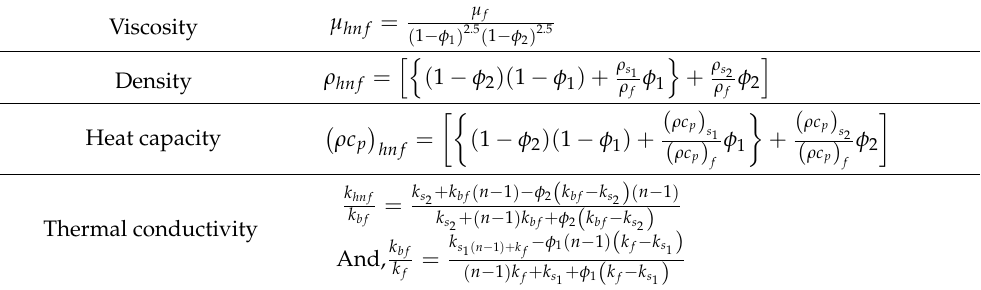
Table 1. Physical properties of hybrid nanofluid.